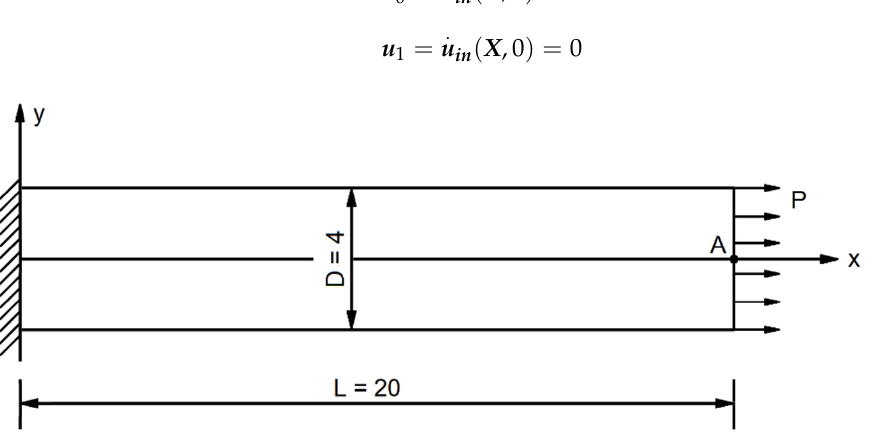
Figure 5. A cantilever beam subjected to horizontal traction.